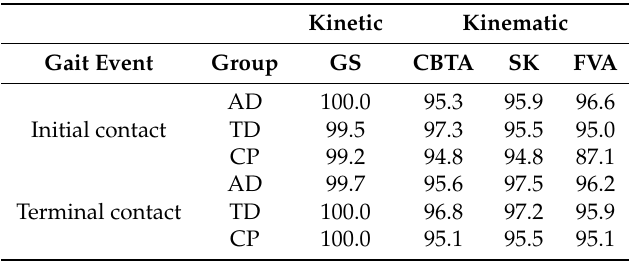
Table 3. Percent gait detection reliability (GDR) of gait event detection methods (GEDM).